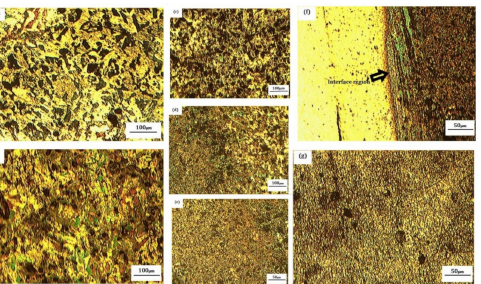
Figure 15. Microstructure analysis of friction surfacing AISI316Ti over EN8 alloy: ( a ) grain structure of the substrate; ( b,c ) grain structure of the mechtrode; ( d–g ) microstructure at the interface